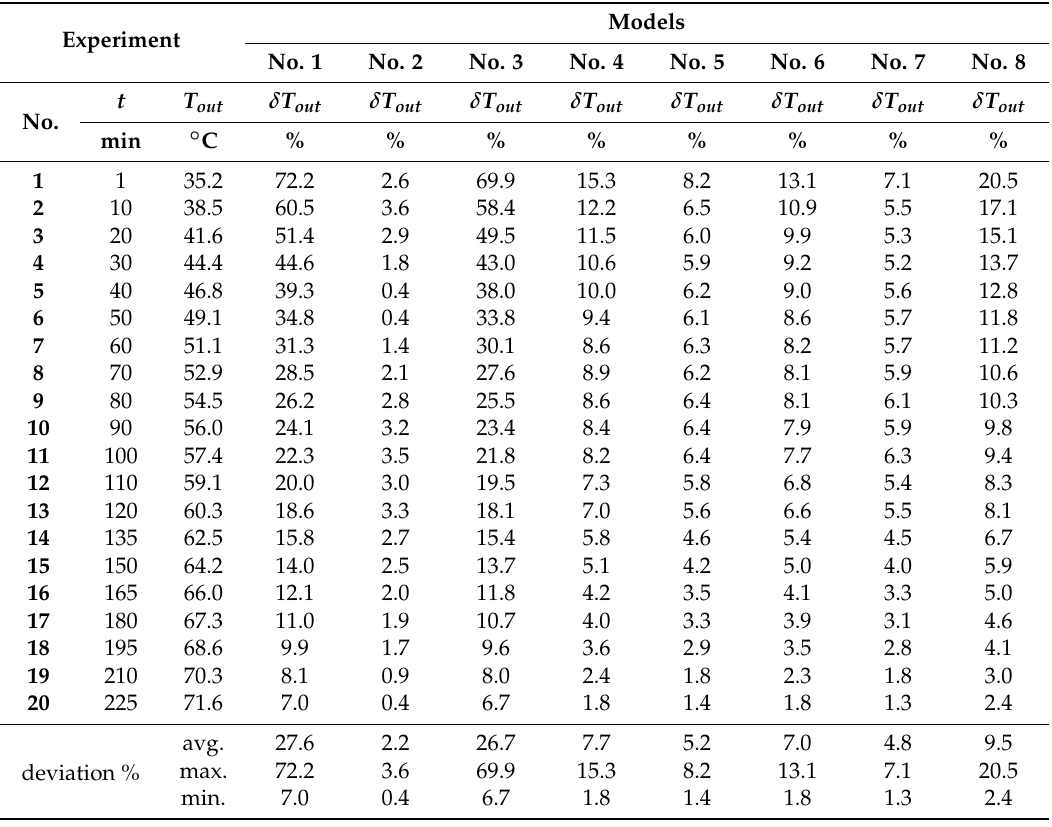
Table 4. Deviations for the airflow of 0.0050 m 3